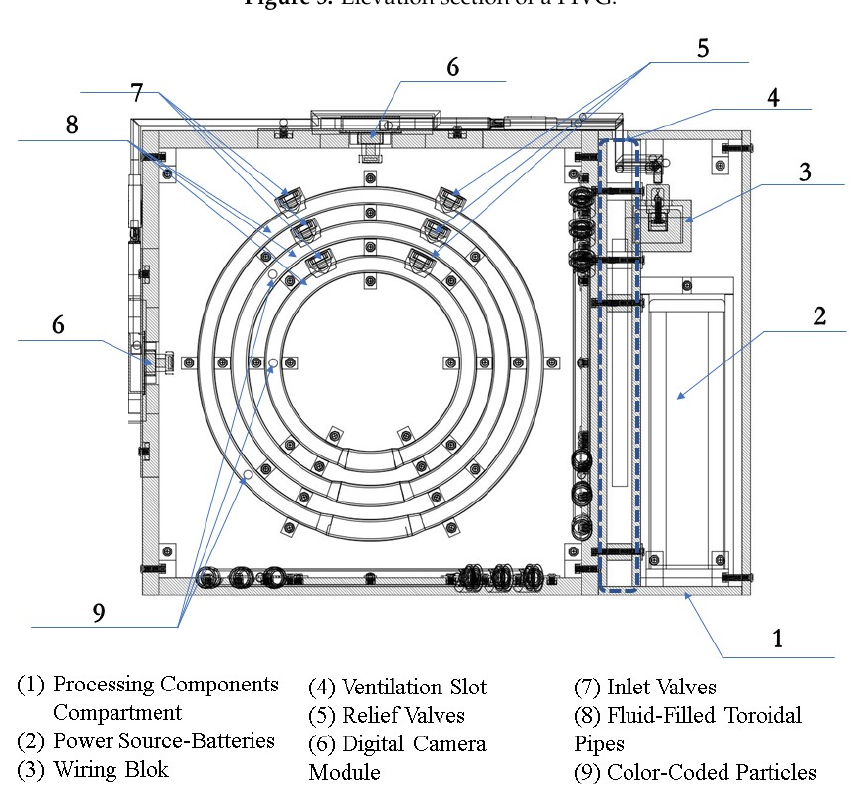
Figure 6. Side view section of a